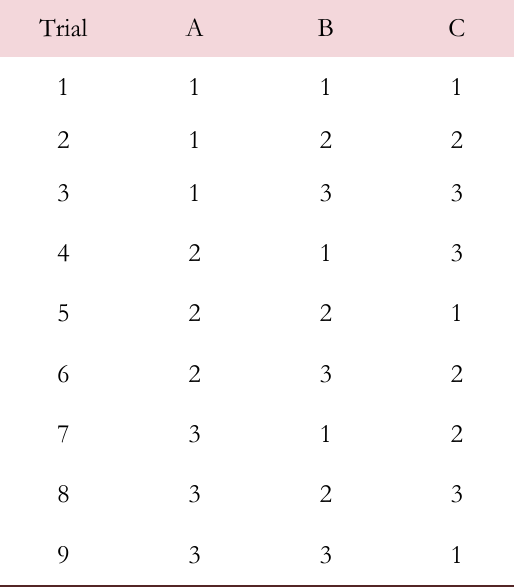
Table 1: Experimental design using L9 OA